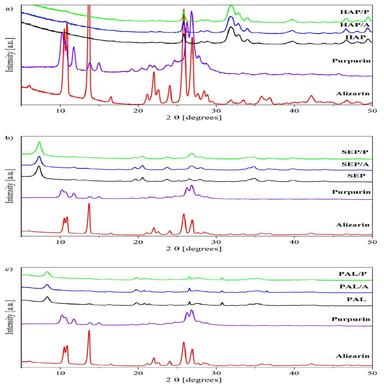
PXRD patterns for organic dyes, inorganic supports, and hybrid pigments.